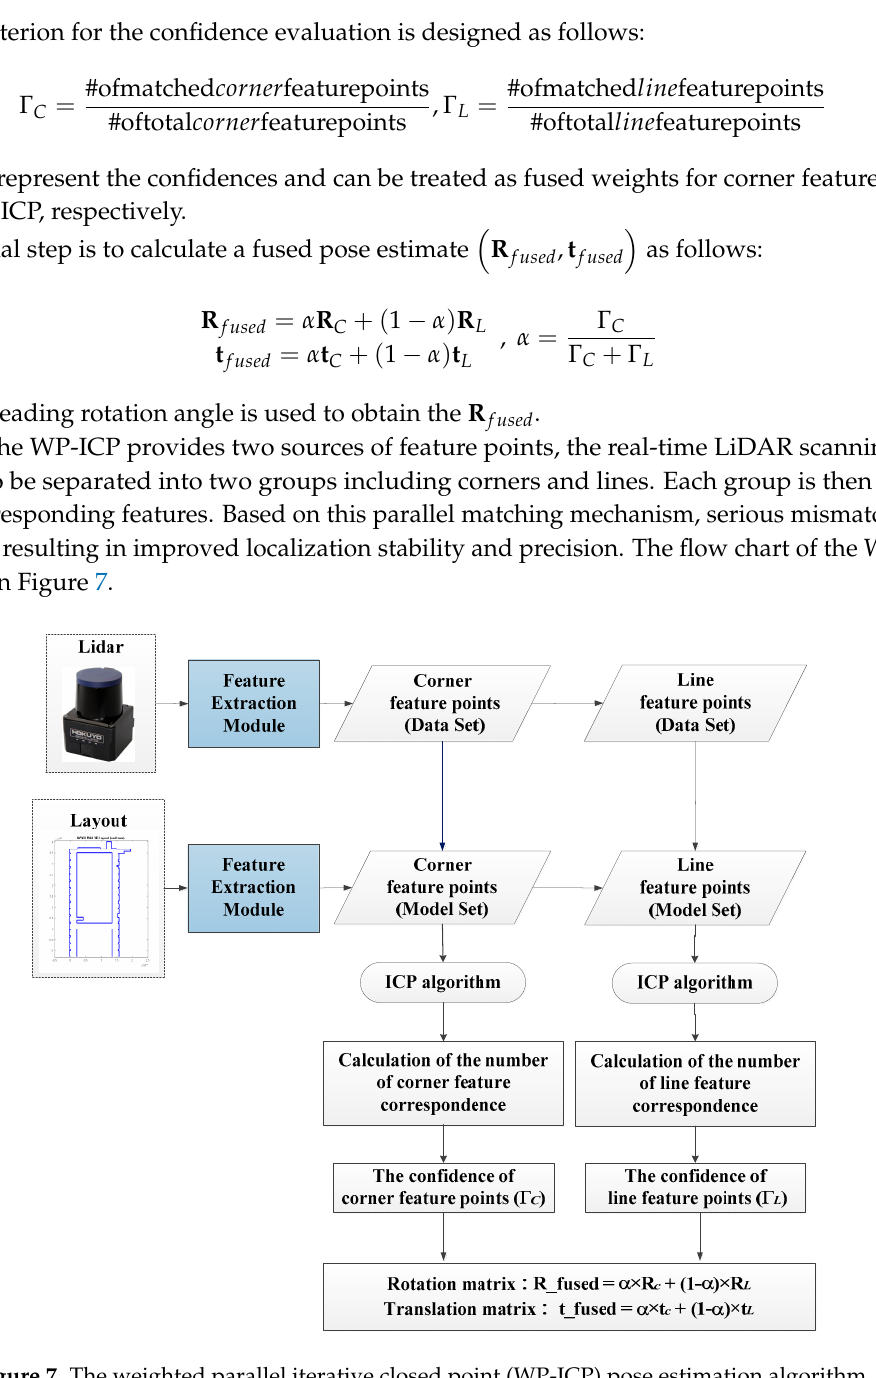
Figure 7. The weighted parallel iterative closed point (WP-ICP) pose estimation algorithm.